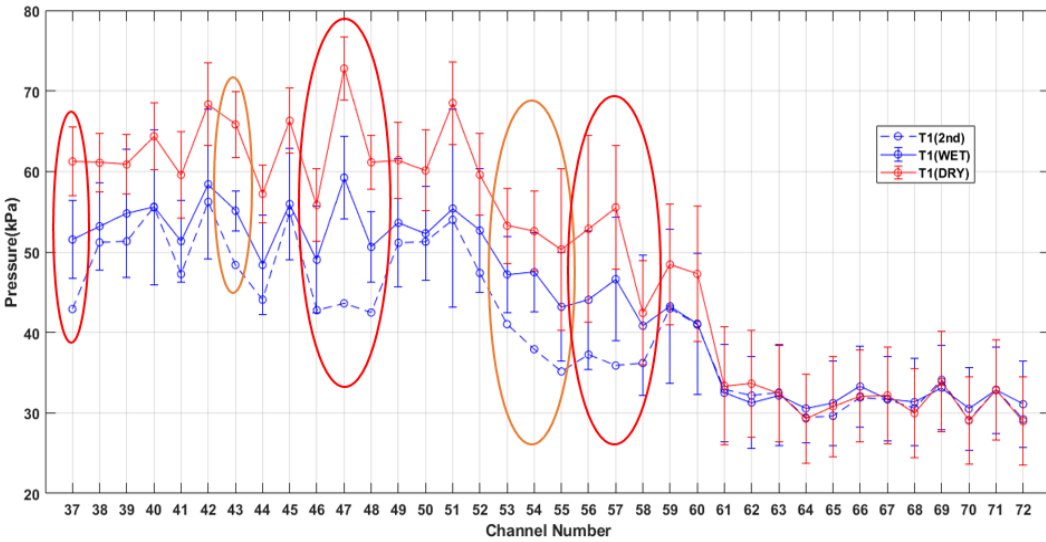
J. Mar. Sci. Eng. 2019 , 7 , x FOR PEER REVIEW Figure 25. Droplet Location of ROLL (the 10 th experiment). Figure 25. Droplet Location of ROLL (the 10th experiment).